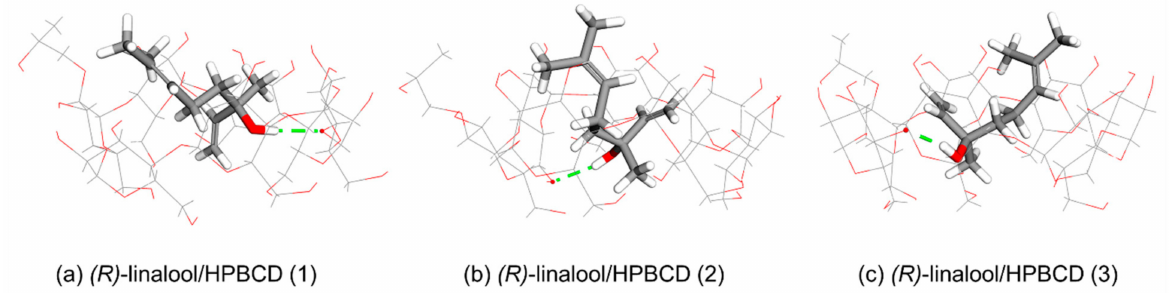
Figure 10. Energy-minimized structure of the 1:1 ( R )-linalool/HPBCD complexes from three clusters using PM7 method. HPBCD is presented as a line model. The linalool molecule is presented as a stick model. The green dashed line refers to hydrogen bond.